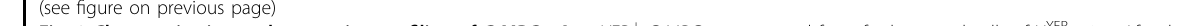
Fig. 2 Characterization and expression pro fi ling of C-MPCs. A :. a YFP + C-MPCs were sorted from fresh stromal cells of X YFP mice. After being propagated in culture, YFP + C-MPCs were evaluated for MSC characteristics and marker expressions. Left top: marrow cell isolation scheme. Left bottom: a CFU-; b Alizarin red; c Oil red; d Alcian blue staining of YFP + C-MPCs. Right panel: FACS analyses of MSC, hematopoietic, and endothelial cell marker expression of the YFP + stromal cells sorted from 2-month-old X YFP mice. b . Quantitative comparison of C-MPCs from X/CKO Tomato (CKO), X/ Δ EX Tomato ( Δ EX) mutant and X Tomato (Con) control mice. Left: bone marrow cells were isolated from 5-week-old mice and directly subjected to FACS, n = 6, * p < 0.05. Right: bone marrow cells isolated from 3-week-old mice were cultured and then subjected to FACS. c . Tm + cells were sorted from stromal cells and subjected to differentiation assays in vitro. Left: Von Kossa staining of Tm + stromal cells after being cultured in osteogenic media for 21 days. Lenti- β -catenin-infected β -catenin – Tm + stromal cells from X/CKO Tomato mice were able to form mineralized nodules. Middle: in vitro adipogenic assay: after being induced for 2 days, the β -catenin – Tm + stromal cells already became adipocytes shown by Oil red staining, not the control C-MPCs. Right: CFU-F image of the β -catenin – Tm + stromal cells and quantitative comparison of Tm + CFU-Fs, n = 6, ****p < 0.0001. d . Left: p10 ROSA26R-Tomato (Tm/Con) and Agc1-CreERT2;ROSA26R-Tomato (iAgc) mice were injected with tamoxifen and bone marrow cells were analyzed by fl ow at day 4 and day 10 post treatment, n = 3, * p < 0.05. Right: p13 Ctnnb1 fl / + ;ROSA26R-Tomato (Con), Agc1-CreERT2;Ctnnb1 fl / + ;ROSA26R- Tomato (iAgc/Con) and Agc1-CreERT2;Ctnnb1 fl / fl . ROSA26R-Tomato (iAgc/CKO) mice were injected with tamoxifen. After a 10-week chase, bone marrow cells were harvest for fl ow analysis. B RNA-seq analyses. Illustration of sample preparation and gene expression log-log plot. See legend in ( A ) for mice detail. C-MPC RNAs were isolated from C-MPCs sorted from fresh stromal cells of 5-week-old mice. Chondrocyte RNAs were extracted from chondrocytes dissected from growth plates of p6